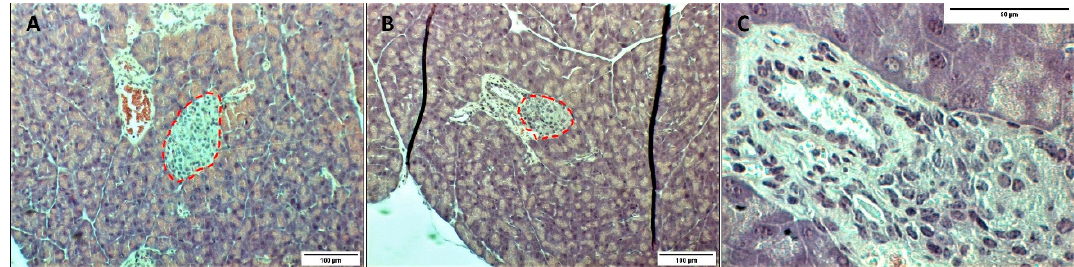
Figure 4. Histological images of pancreatic tissue from STZ-induced diabetic female mice on day 7 ( A ), and day 14 ( B ) after transplantation, where ( C ) depicts a higher magnification for day 14 after transplantation. Islets are circled in red. Tissues were stained using haematoxylin and eosin.